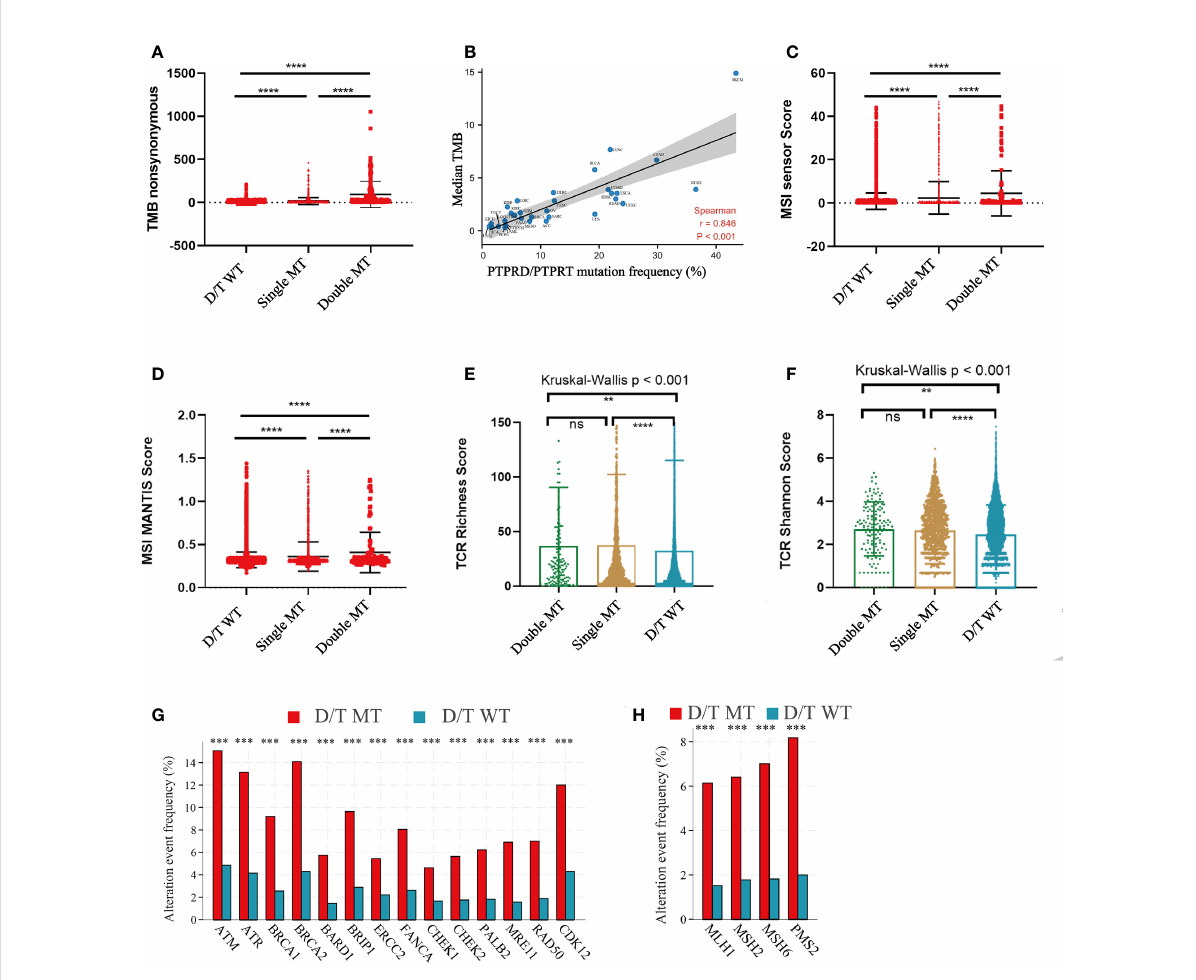
FIGURE 7 The correlation between PTPRD/PTPRT mutation and multiple predictive variables for ICIs. (A) TMB levels among PTPRD/PTPRT WT, single- mutant, and double-mutant tumors. (B) The correlation between PTPRD/PTPRT mutation frequency and median TMB score across tumors. (C) MSI sensor scores among PTPRD/PTPRT WT, single-mutant, and double-mutant tumors. (D) MSI MANTIS scores among PTPRD/PTPRT WT, single-mutant, and double-mutant tumors. (E) TCR richness scores among PTPRD/PTPRT WT, single-mutant, and double-mutant tumors. (F) TCR Shannon scores among PTPRD/PTPRT WT, single-mutant, and double-mutant tumors. (G) The correlation between DDR-genes mutation and PTPRD/PTPRT mutation. (H) The correlation between MMR-gene mutation and PTPRD/PTPRT mutation (** P < 0.01, *** P < 0.001, **** P < 0.0001, ns, no signi fi cance). TMB, tumor mutational burden; MSI, microsatellite instability; MANTIS, Microsatellite Analysis for Normal- Tumor InStability; TCR, T-cell receptor; DDR, DNA damage response; MMR, mismatch